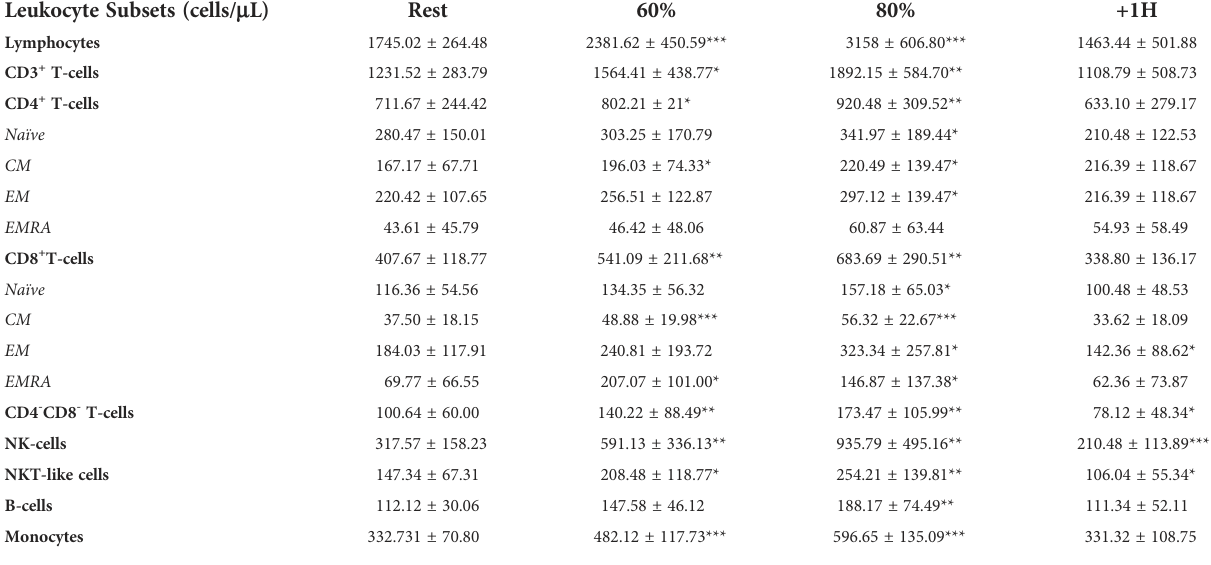
TABLE 1 The total number (cells/ m L) of lymphocytes, CD3+ T-cells, CD4+ T-cells, CD8+ T-cells, ‘ double negative ’ T-cells, NK-cells, NKT-like cells, B-cells, and monocytes present in peripheral blood before (rest), during (at 60% and 80% VO 2max ), and 1-hour post (+1H) exercise. Leukocyte Subsets (cells/ m